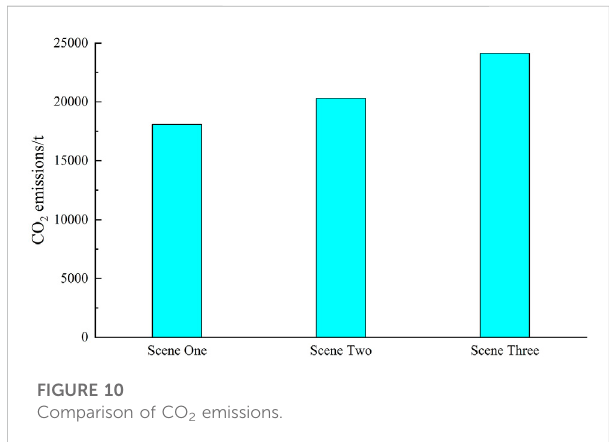
FIGURE 10 Comparison of CO 2